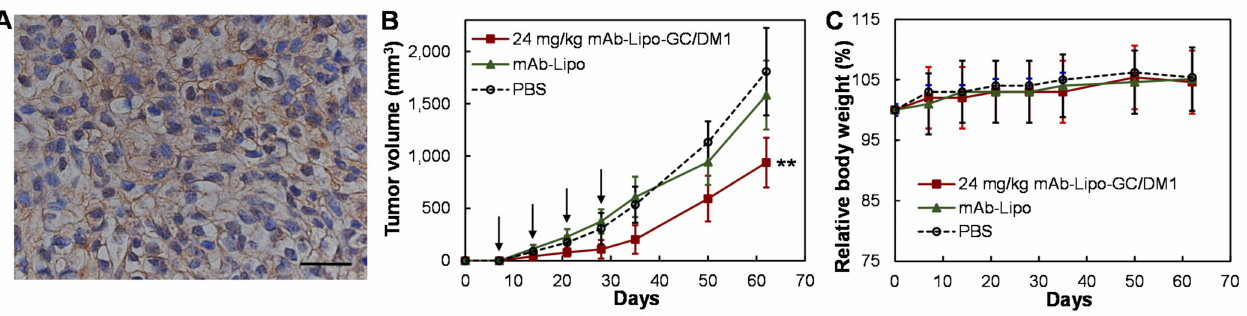
Figure 6. In vivo anti-TNBC efficacy of mAb-Lipo-drugs in PDX models. ( A ) Representative images of IHC staining of the PDX xenograft tissues showing strong EGFR surface expression in J000103634 line. Scale bar equals to 20 µ m. ( B ) Tumor volume post treatment ( n = 4). PBS ( ), drug delivering vehicle mAb-Lipo ( (cid:78) ), and 24 mg/kg mAbs-Lipo-GC/DM1 ( (cid:4) ). (cid:35) Arrow indicating the i.v. injection of control or therapies. ( C ) The normalized body weight after treatment. ** p <0.005 vs. PBS using ANOVA followed by Dunnett’s t